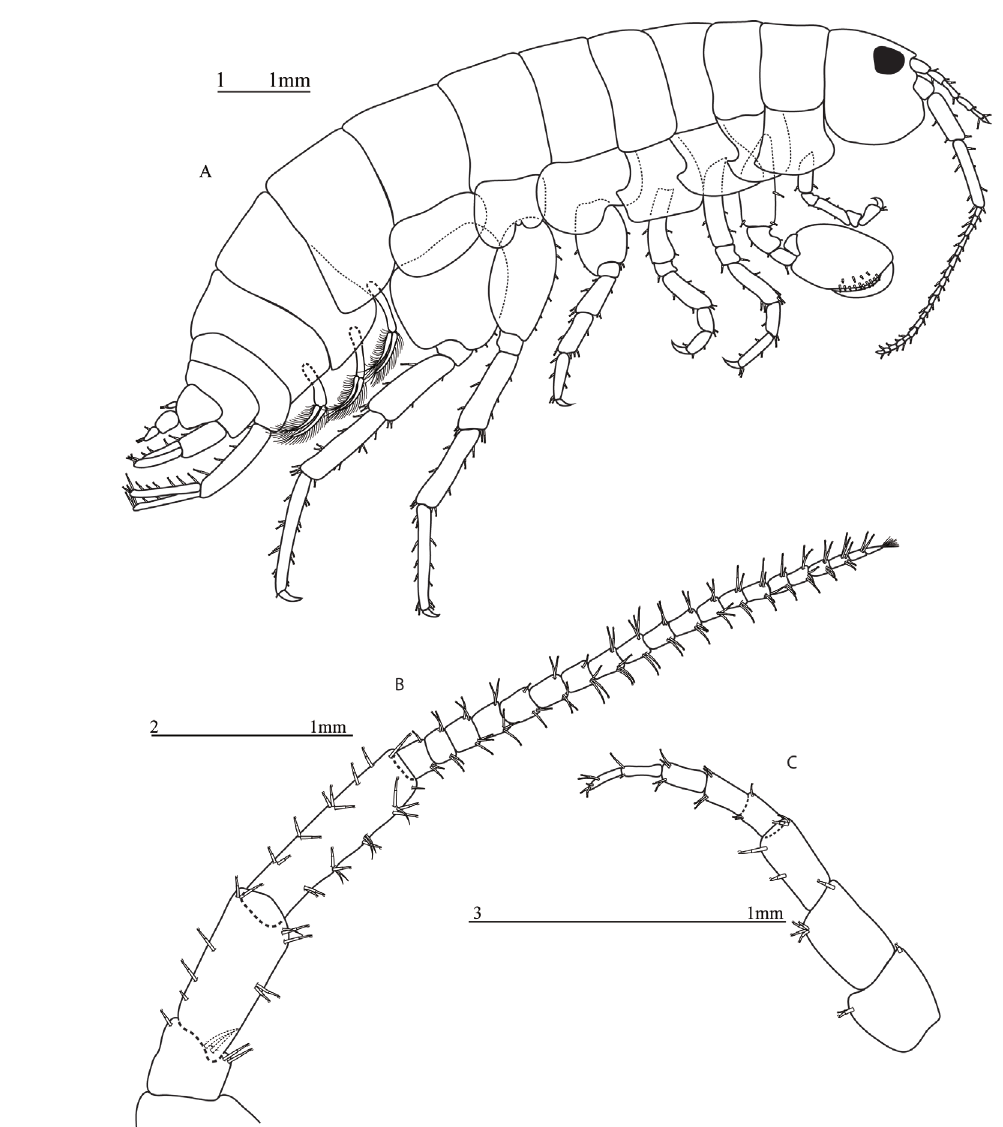
Fig. 1. Cerrorchestia taboukeli sp. nov., holotype, ♂, 11.3 mm, MNHN-IU-2019-2276. A . Habitus (scale 1). B . Second antenna (scale 2). C . First antenna (scale